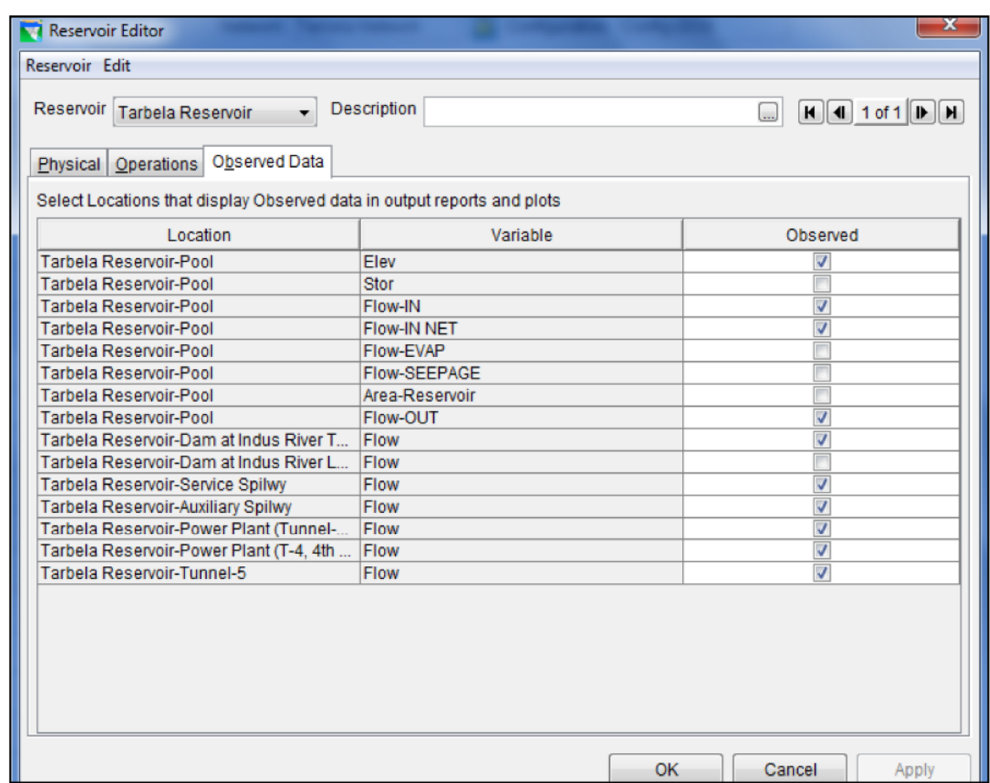
Figure 17. Physical Input data of Tarbela dam and reservoir.